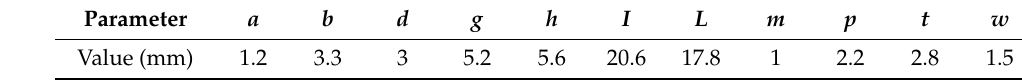
Figure 1. Proposed antenna view ( a ) front ( b ) antenna elements with decoupling element. Table 1. Proposed antenna dimensions. Table 1. Proposed antenna dimensions.